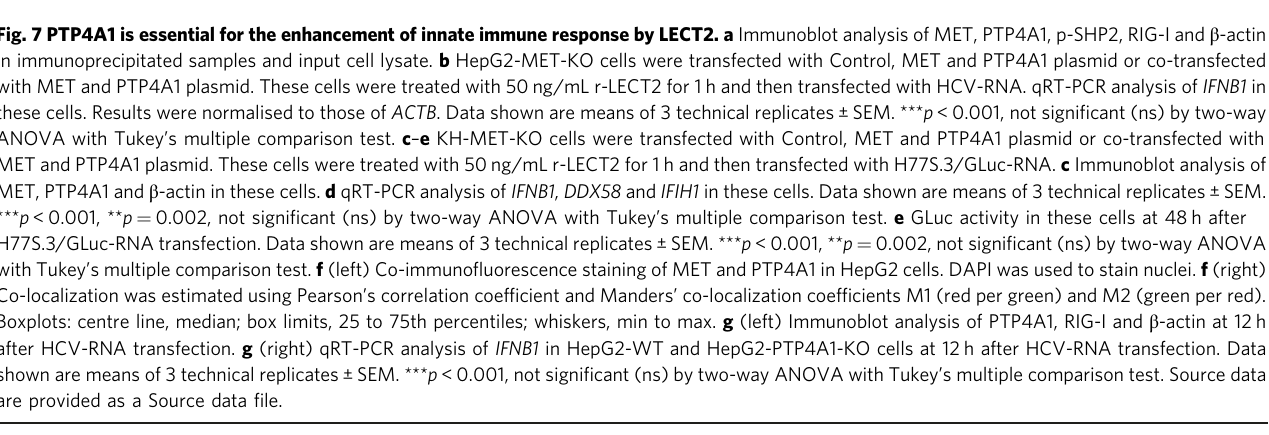
Fig. 7 PTP4A1 is essential for the enhancement of innate immune response by LECT2. a Immunoblot analysis of MET, PTP4A1, p-SHP2, RIG-I and β -actin in immunoprecipitated samples and input cell lysate. b HepG2-MET-KO cells were transfected with Control, MET and PTP4A1 plasmid or